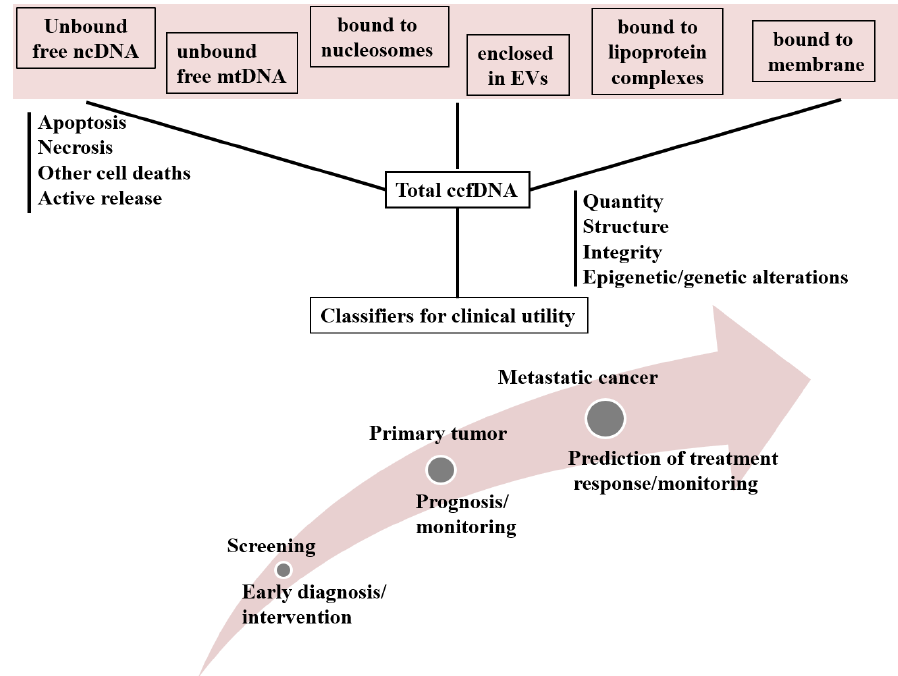
Figure 1. Circulating structures of ccfDNA in human plasma and their applications in clinical management of cancer. Abbreviations: BC=Breast Cancer; ccfDNA=circulating cell free DNA; Evs=Extracellular Vesicles; MBC=Metastatic Breast Cancer; mtDNA=Mitochondrial DNA; ncDNA=Nuclear DNA.